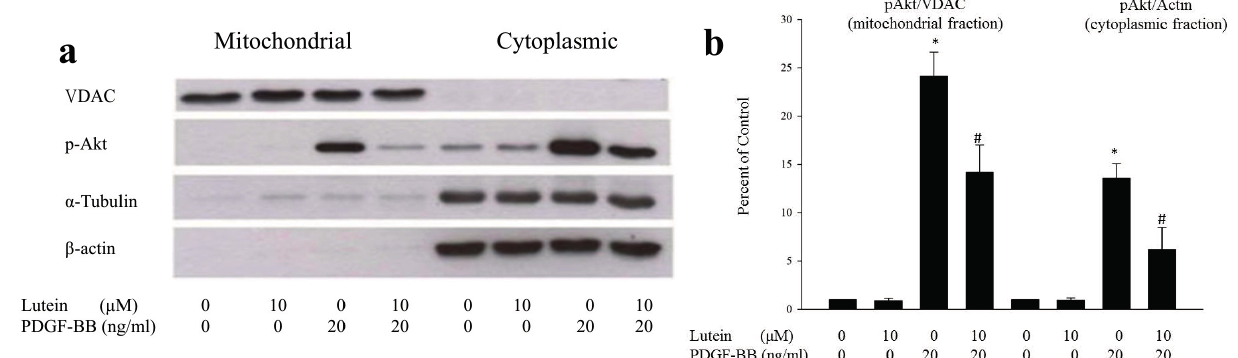
Figure 2. Effects of PDGF and lutein on RPE cells ( a ) The Western blot showed the stimulatory effect of PDGF at the concentration of 20ng/mL, and the inhibitory effect of lutein at the concentration of 10 μ M on phopho-Akt in both the cytoplasmic and mitochondrial compartments. In this diagram, α -tubulin and β -actin represent the markers of cytosolic fraction of RPE cells, and voltage-dependent anion channel (VDAC) represents the marker of mitochondria fraction. The results presented are representative of five independent experiments; ( b ) The bar graph represented the data summarized from five experiments. These data were normalized to the contents of VDAC in mitochondrial fraction and actin in